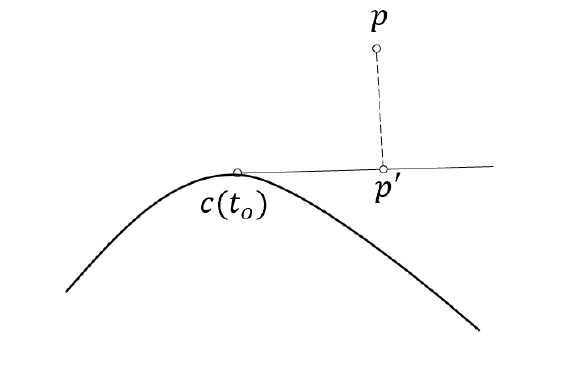
Figure 8. Schematic diagram of point projection on curve.